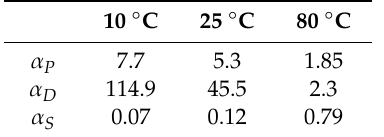
Table 7. Selectivity of methane / butane for